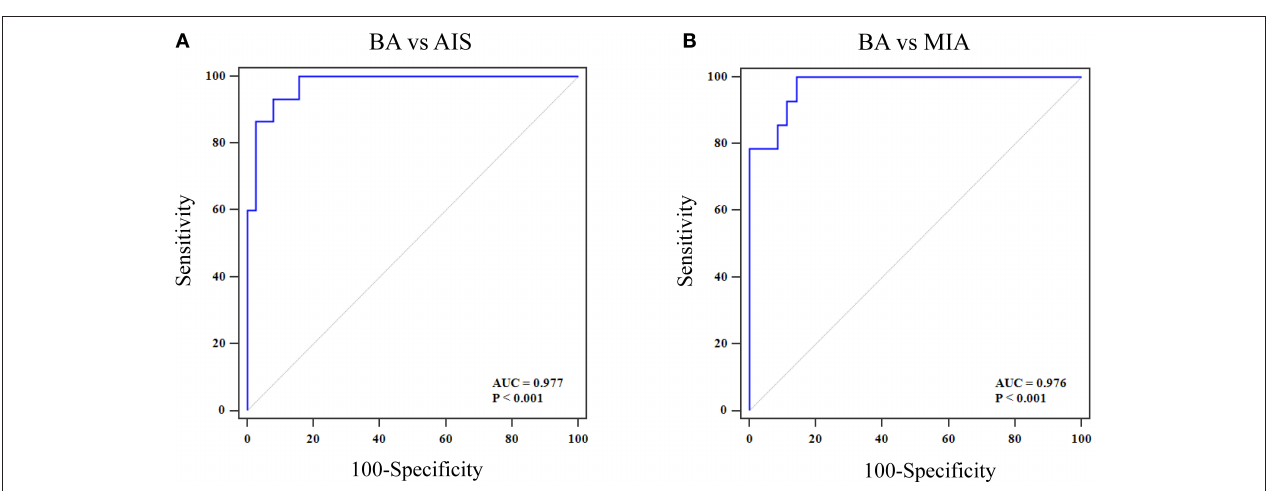
FIGURE 6 | ROC curve of a comprehensive model with six selected texture features for distinguishing BA from AIS/MIA. (A) For BA vs. AIS, the AUC value, specificity, and sensitivity were 0.997, 92.1, and 93.3%, respectively. (B) For BA vs. MIA, the AUC value, specificity, and sensitivity were 0.976, 85.7, and 99.9%,